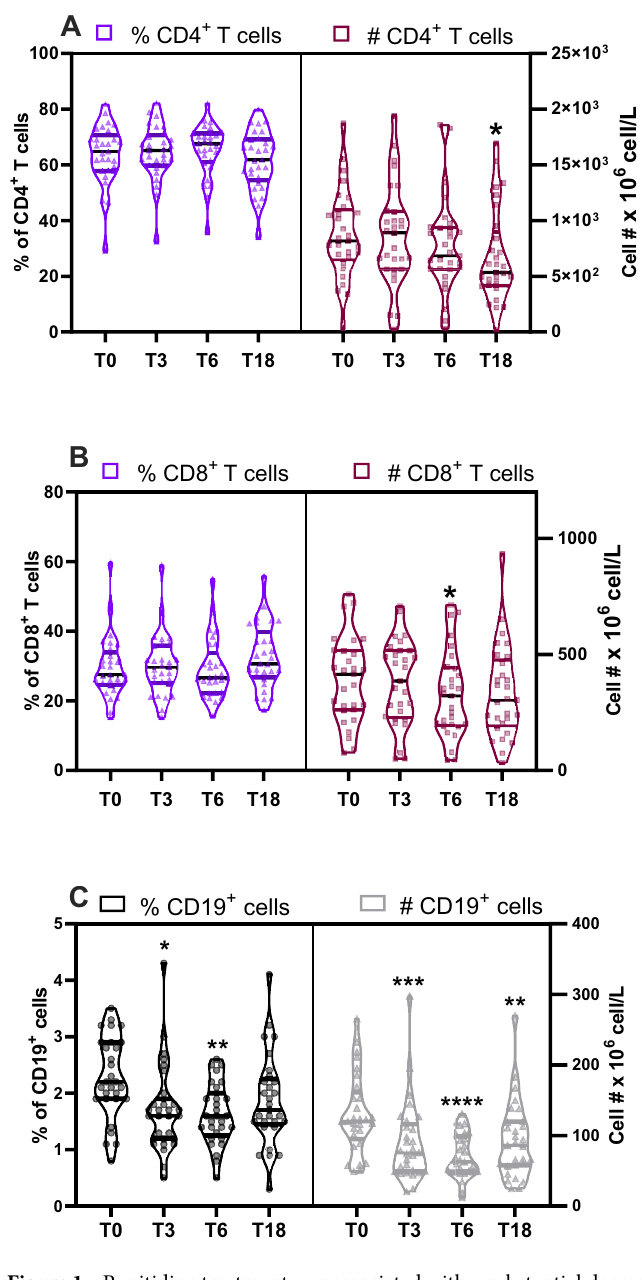
Figure 1. Ranitidine treatment was associated with a substantial decrease of CD19 + B cells: The percentage and number of peripheral blood CD4 + ( A ), CD8 + T cells ( B ) and CD19 + cells ( C ) were assessed before ranitidine treatment (T0), after 3- and 6-weeks treatment (T3 and T6), and 12 weeks after treatment cessation (T18) by flow cytometry. Statistical analysis was performed using repeated measures Friedman’s test with Dunn’s multiple comparison using T0 as control. Graphs depict median and IQR, n = 29. *P < .05; **P < .01; ***P < .001; ****P <